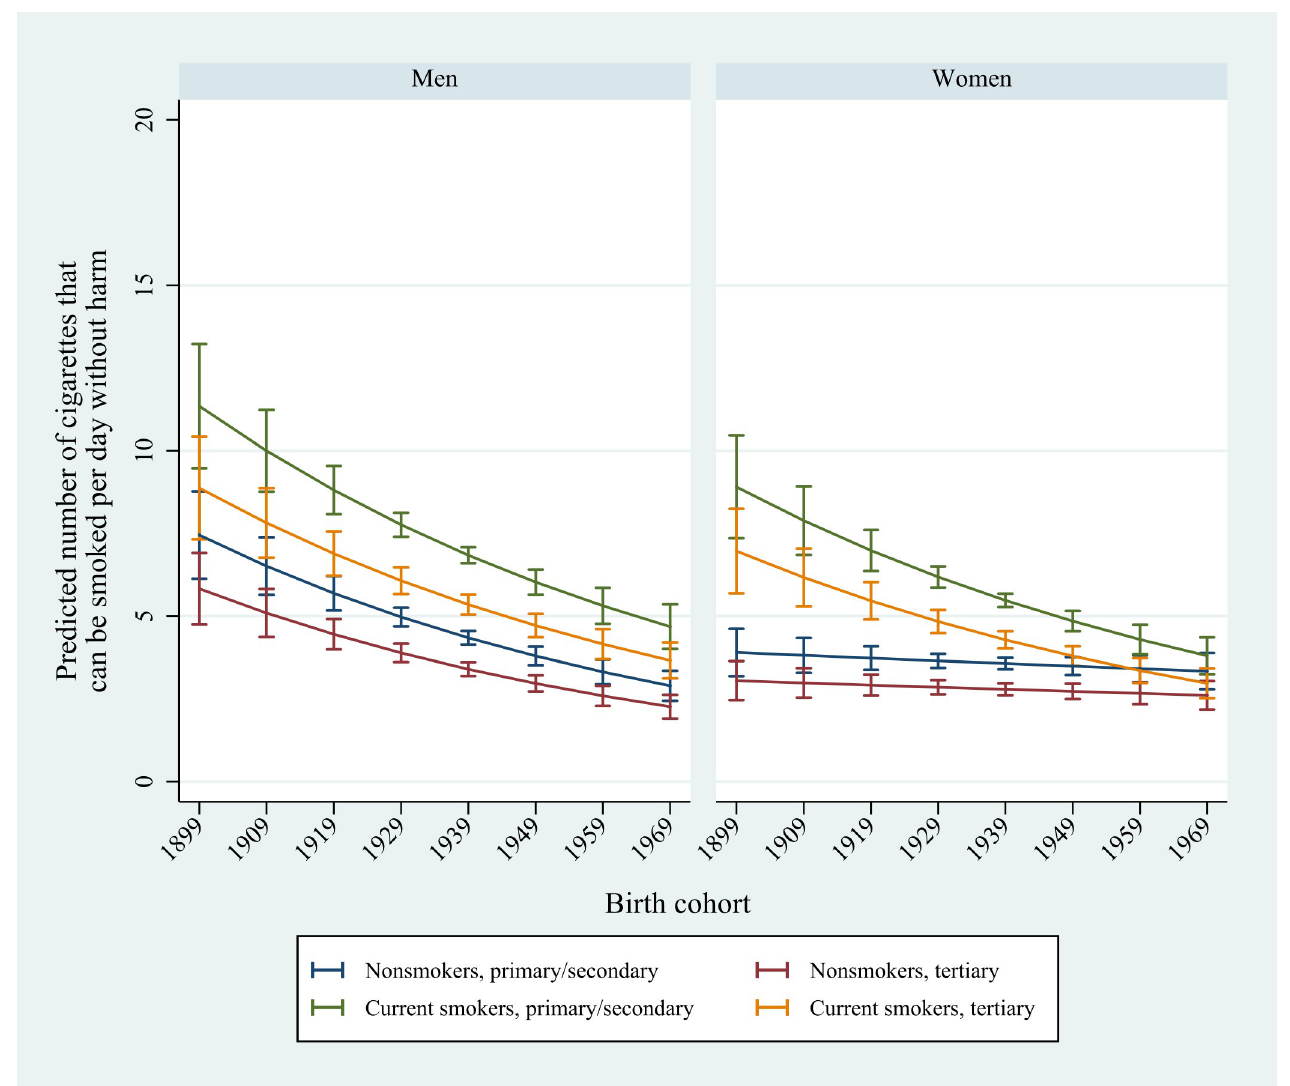
Fig 2. Predicted number of cigarettes that can be smoked per day without causing harm. Male and female smokers and non-smokers with primary/ secondary or tertiary education born in the period 1899 to 1969 (Model